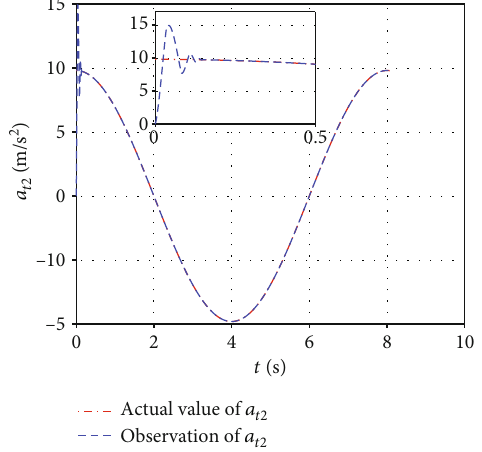
Figure 30: Target acceleration estimation in the lateral plane.